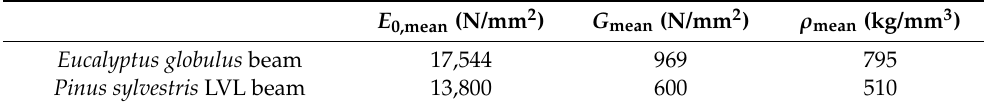
Figure 10. Geometrical ( top ) and numerical ( down ) models of the gridshell and detail of a nodal joint. Table 4. Material properties of Eucalyptus globulus and Pinus sylvestris LVL beam elements used in the numerical model: mean modulus of elasticity parallel to grain ( E 0,mean ), mean shear modulus ( G mean ), and mean density ( ρ mean ).